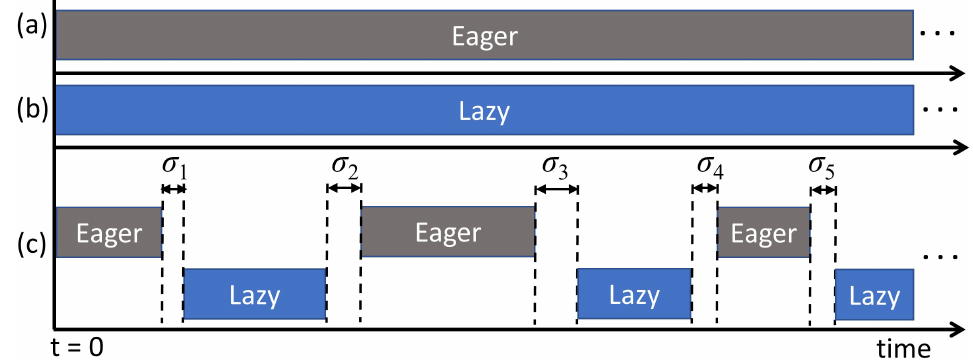
Figure 4. An illustration of ( a ) eager, ( b ) lazy, and ( c ) basic adaptive versioning. The time gap σ ∗ while switching from eager (lazy) to lazy (eager) is to let finish executing in-flight transactions. This helps in avoiding potential data versioning